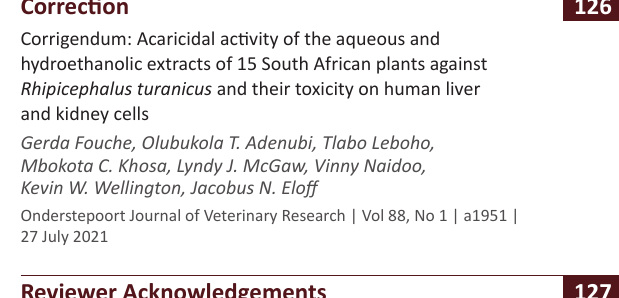
Corrigendum: Investigation of the acaricidal activity of the acetone and ethanol extracts of 12 South African plants against the adult ticks of Rhipicephalus turanicus